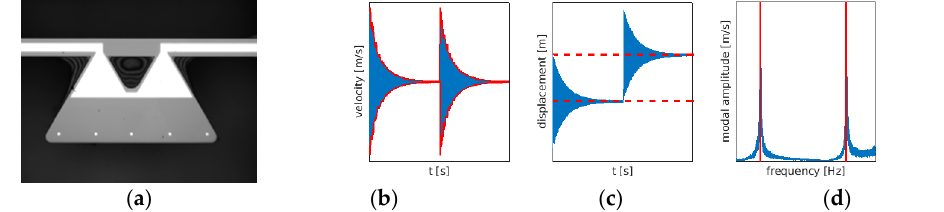
Figure 2. ( a ) Top view of a 300 µm long and 3.1 µm thick twin-fin flapper with a one electrode design. ( b – d ) Calibration of the piezoelectric mechanically coupled simulations by: ( b ) Decay curves from the step response to extract the damping coefficient; ( c ) static deflection of the flapper to extract d 31 of the AlN layer and ( d ) measurement of the resonant